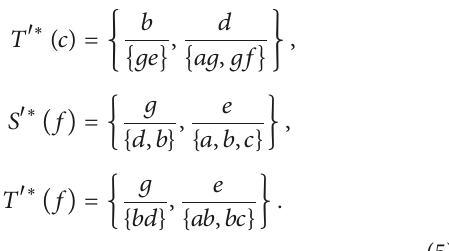
Figure 6: G 󸀠∗ = (𝐻 󸀠∗ (𝑐), 𝐻 󸀠∗ (𝑓))